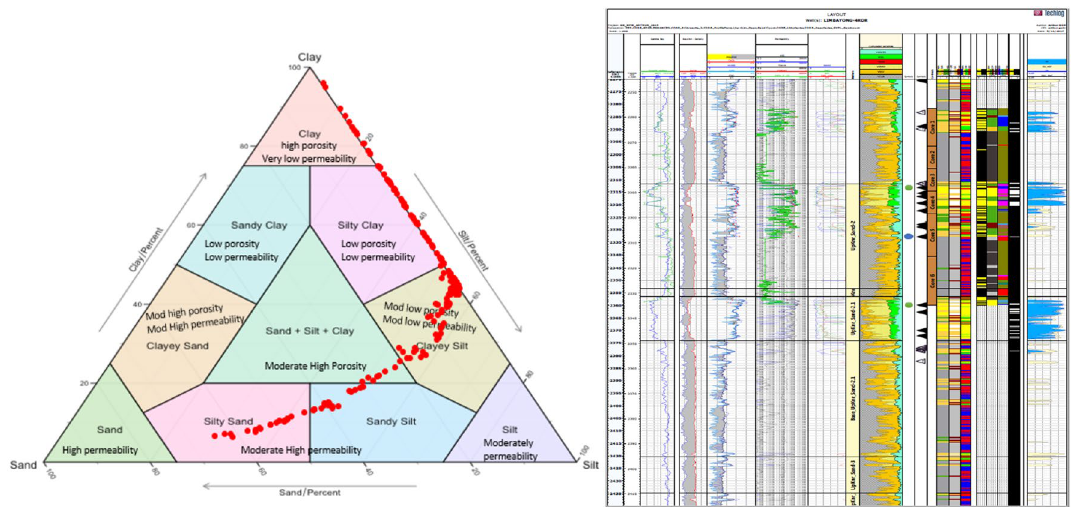
Fig. 15 Ternary diagram for the cored interval in the study